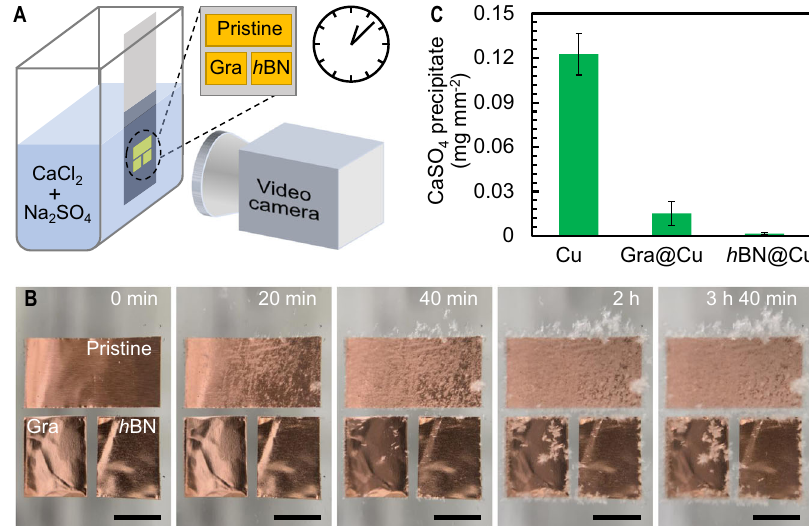
Fig. 1 | Scaling behavior of graphene and h BN caused by both surface-induced heterogeneous nucleation and attachment of mineral crystals formed in the bulk solution through homogeneous nucleation. A Experimental setup and B video snapshots of the pristine Cu (pristine), graphene (Gra) coated Cu